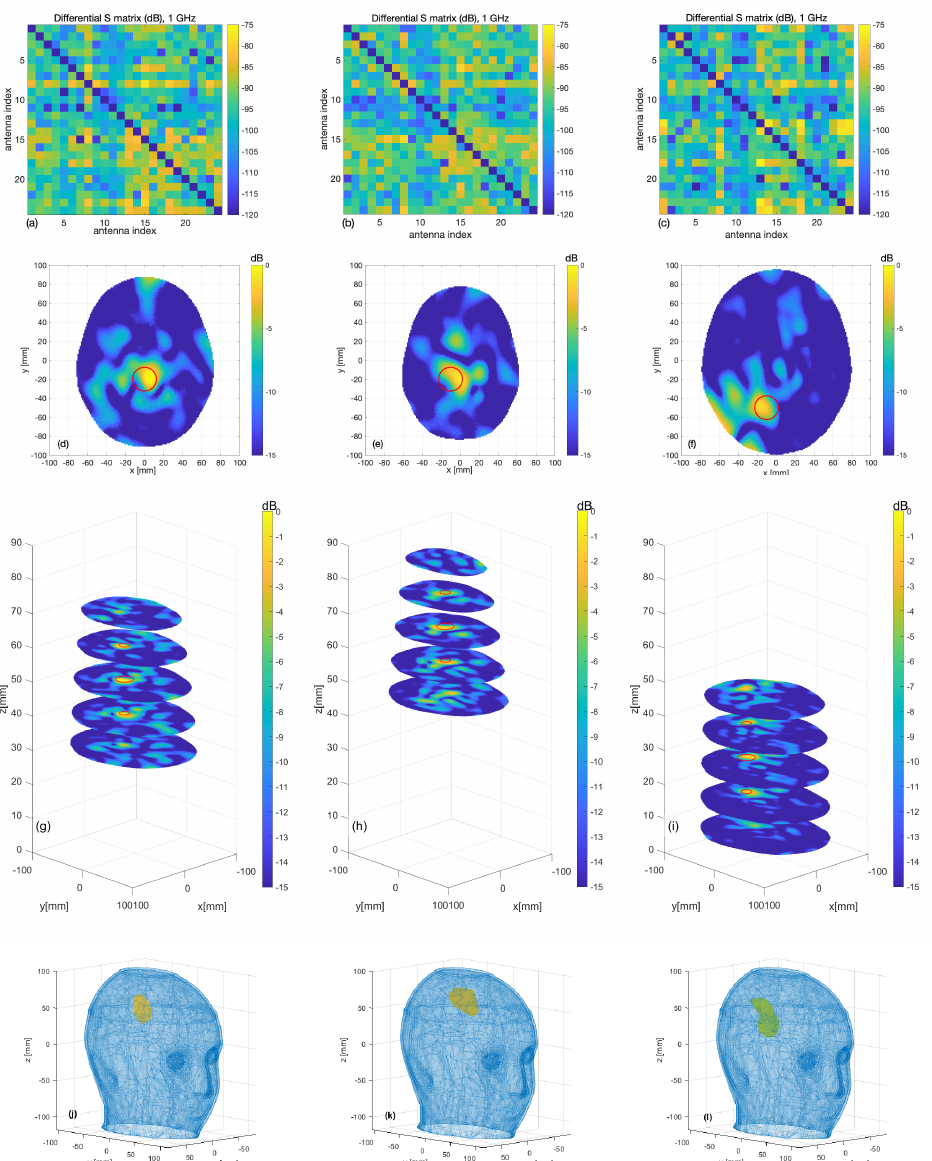
Figure 11. Measurement results: ( a – c ) differential scattering matrices; ( d – f ) horizontal cross-sections at sphere center and ( g – i ) at the various levels as highlighted in Figure 7 (the expected sphere location and shape are indicated by red circles); from left to right, images corresponding to the blue, red and yellow spheres of Figure 7, respectively; ( j – l ) the 3D rendering of the imaged